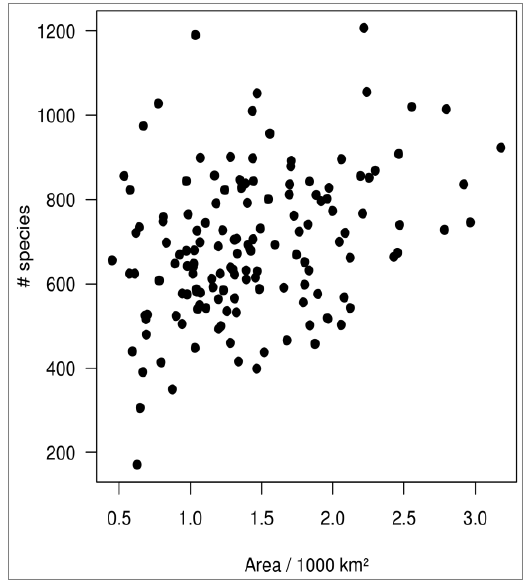
Figure 3. Relationship between county area and number of species per county.